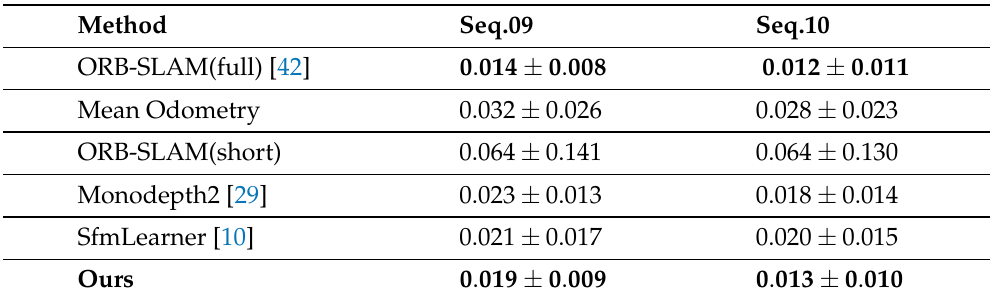
Table 3. Absolute Trajectory Error (ATE) on the KITTI Odometry sequences 09 and 10 (lower is